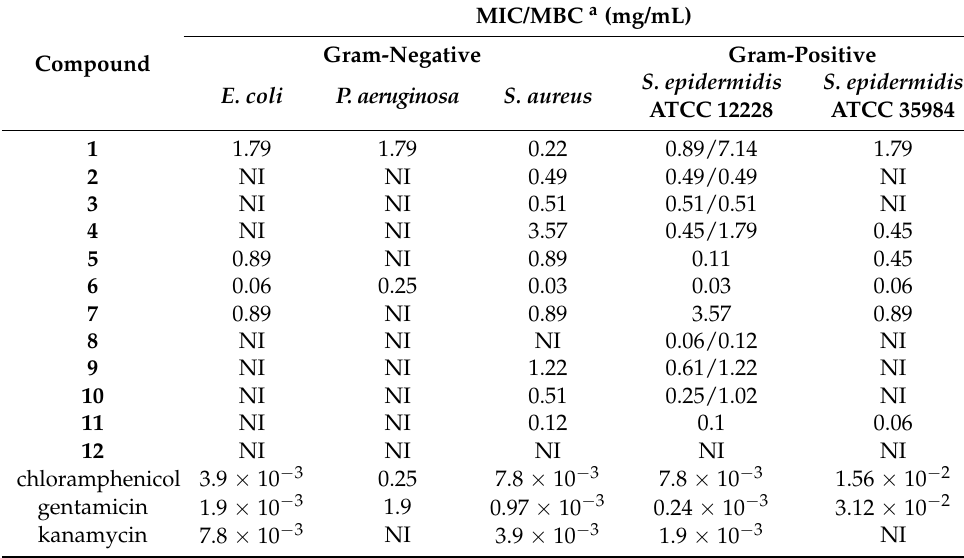
Table 3. Minimal inhibitory concentration (MIC) and minimal bactericidal concentration (MBC) values determined for coumarin–thiadiazole hybrids 1-12